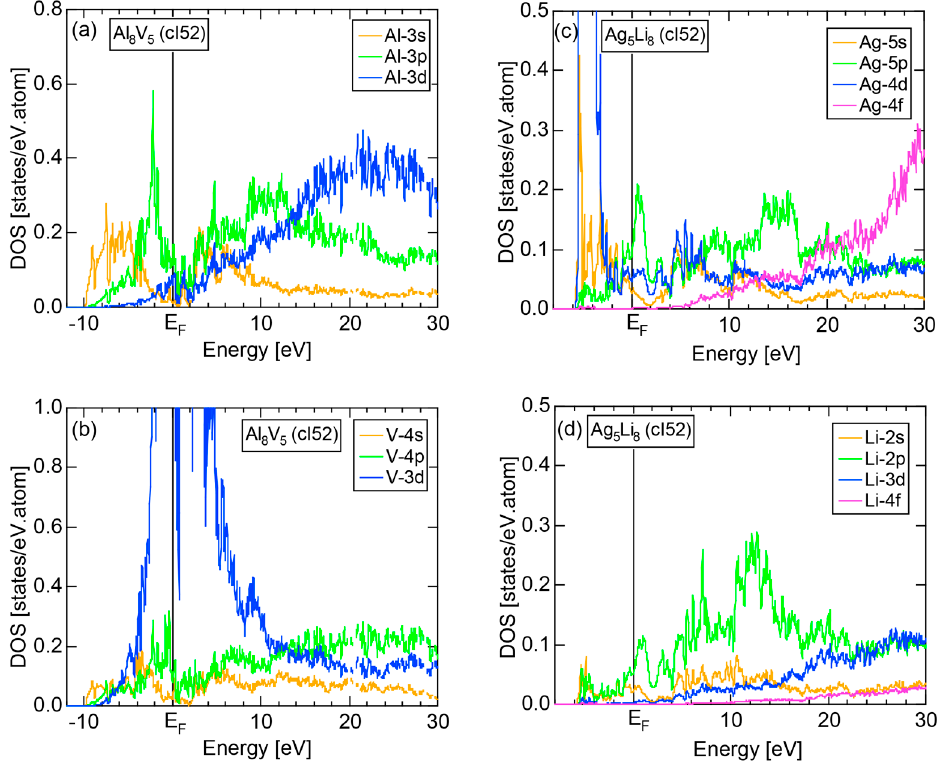
Figure 33. ( a ) Al- and ( b ) V-pDOSs for Al 8 V 5 (cI52) and ( c ) Ag- and ( d ) Li-pDOSs for Ag 5 Li 8 (cI52).